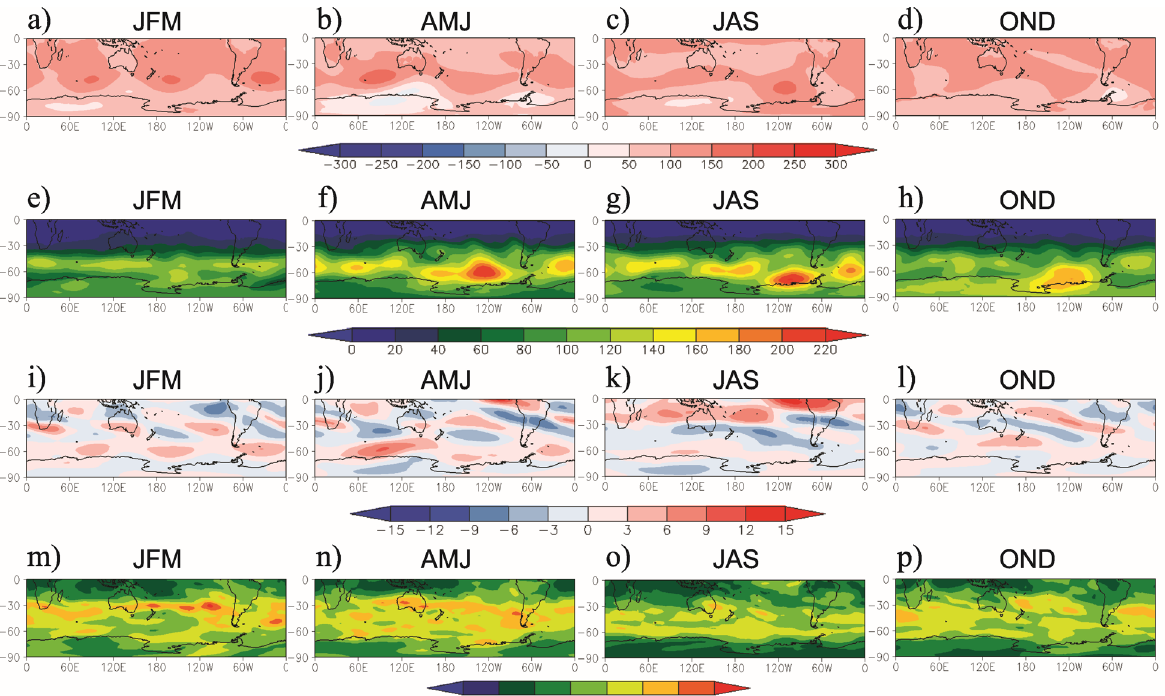
Figure 7. Seasonal difference of (a, b, c, d) 500-hPa geopotential height (m) and (i, j, k, l) 250-hPa zonal wind (ms -1 ) between the NorESM1-M historical experiment and the ERA-Interim reanalysis and standard deviation of (e, f, g, h) 500-hPa geopotential height (m) and (m, n, o, p) 250-hPa zonal wind (ms -1 ) from the NorESM1-M historical experiment during summer (JFM; first column), autumn (AMJ; second column), winter (JAS; third column) and spring (OND; fourth column) over